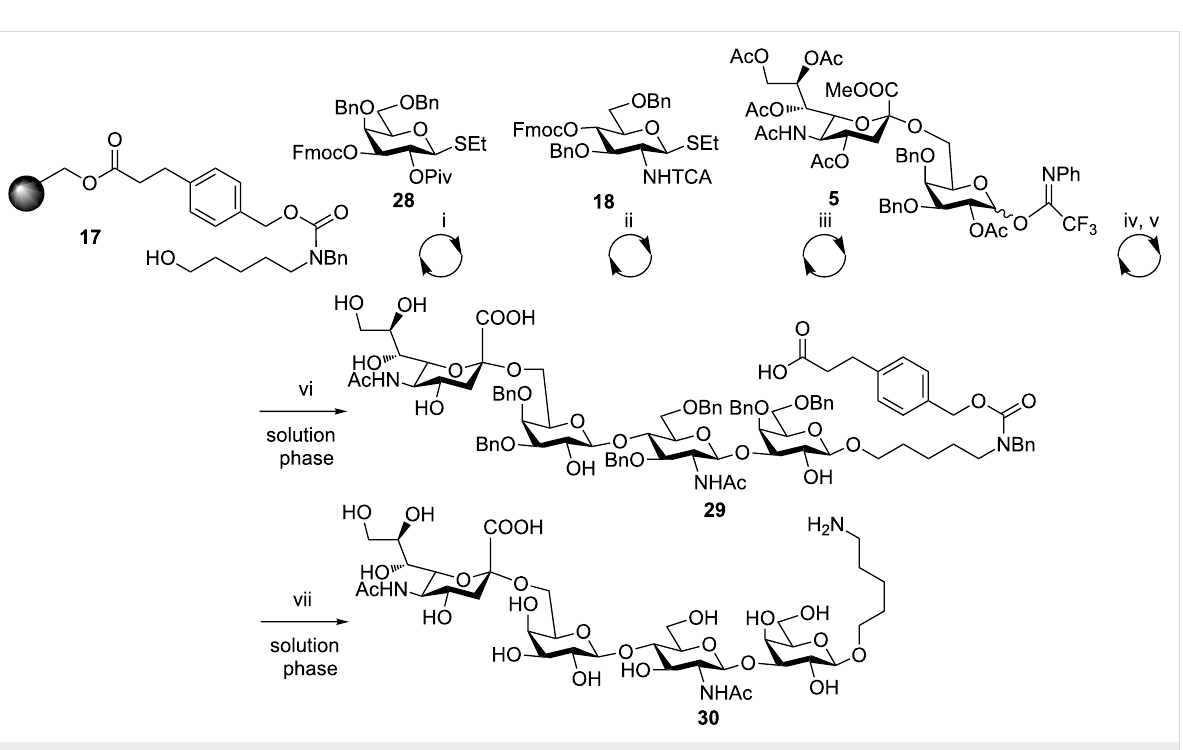
Scheme 6: Automated synthesis of 30 . Reagents and conditions: (i) (a) NIS, TfOH, dioxane, DCM, − 40 to − 20 °C, 40 min; (b) piperidine, DMF. (ii) NIS, TfOH, dioxane, DCM, − 40 to − 20 °C, 40 min. (iii) TMSOTf, Et 2 O, 0 °C, 2 h. (iv) AIBN (cat.), Bu 3 SnH (10 equiv), xylene, 90 °C. (v) NaOMe, MeOH, DCM, 1.5 h. (vi) KOH, MeOH, H 2 O, THF, 60 °C, 16%. (vii) Pd/C, MeOH/H 2 O/EtOAc, cat. AcOH,